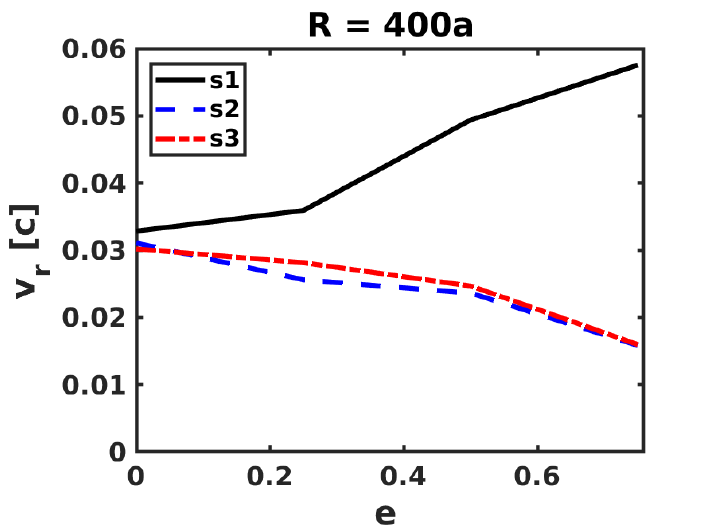
Figure 5. Radial velocity, averaged over sectors s1, s2 and s3 at R = 400 a , versus orbital